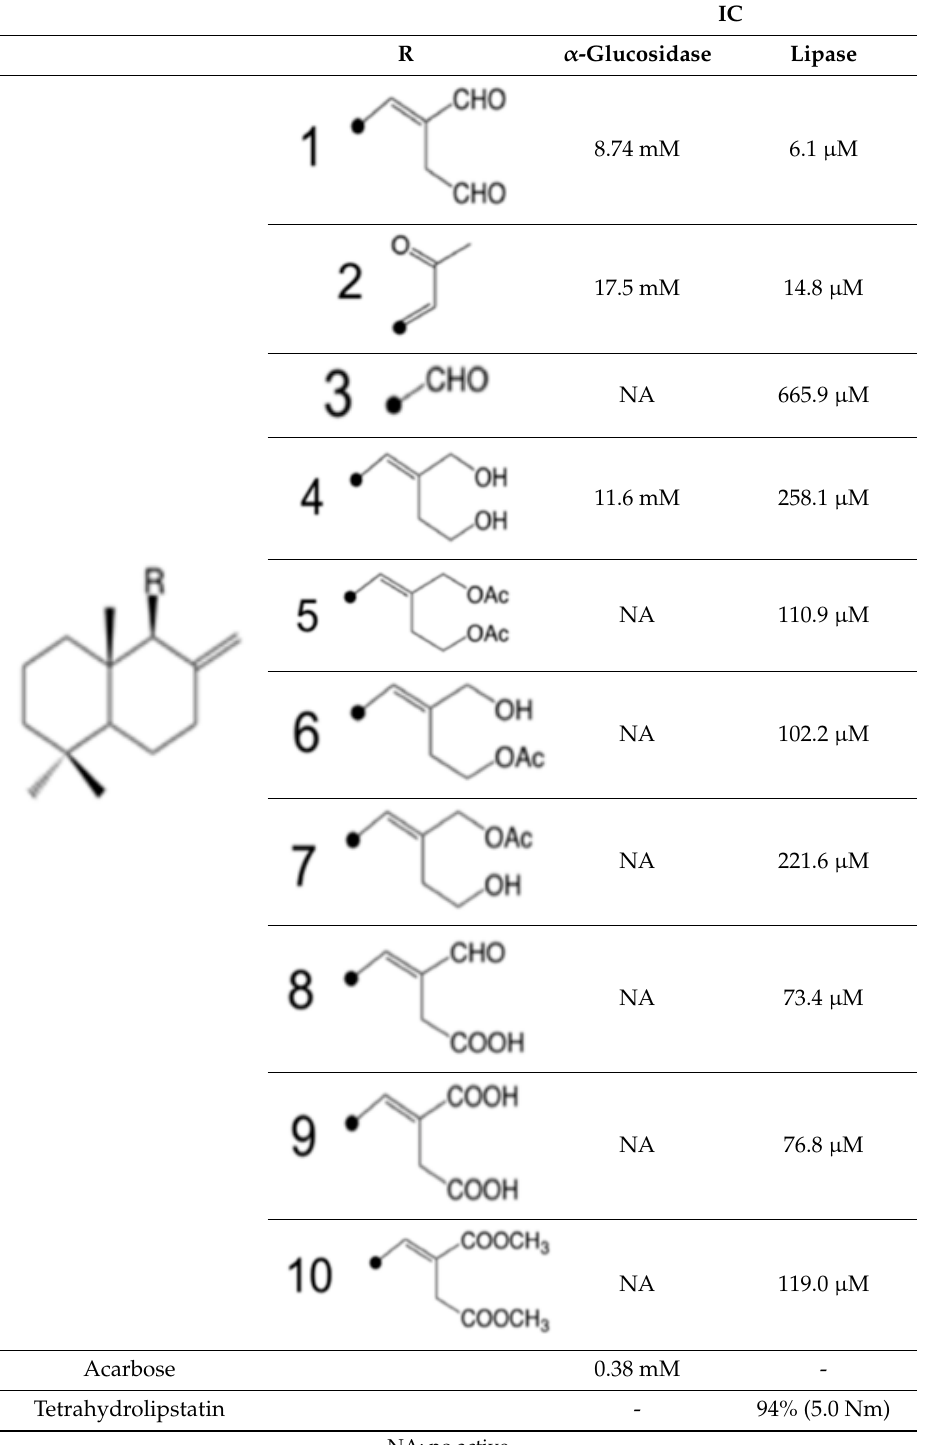
Table 1. α -Glucosidase inhibitory and lipase activities of labdane diterpene from mango ginger and its derivatives.